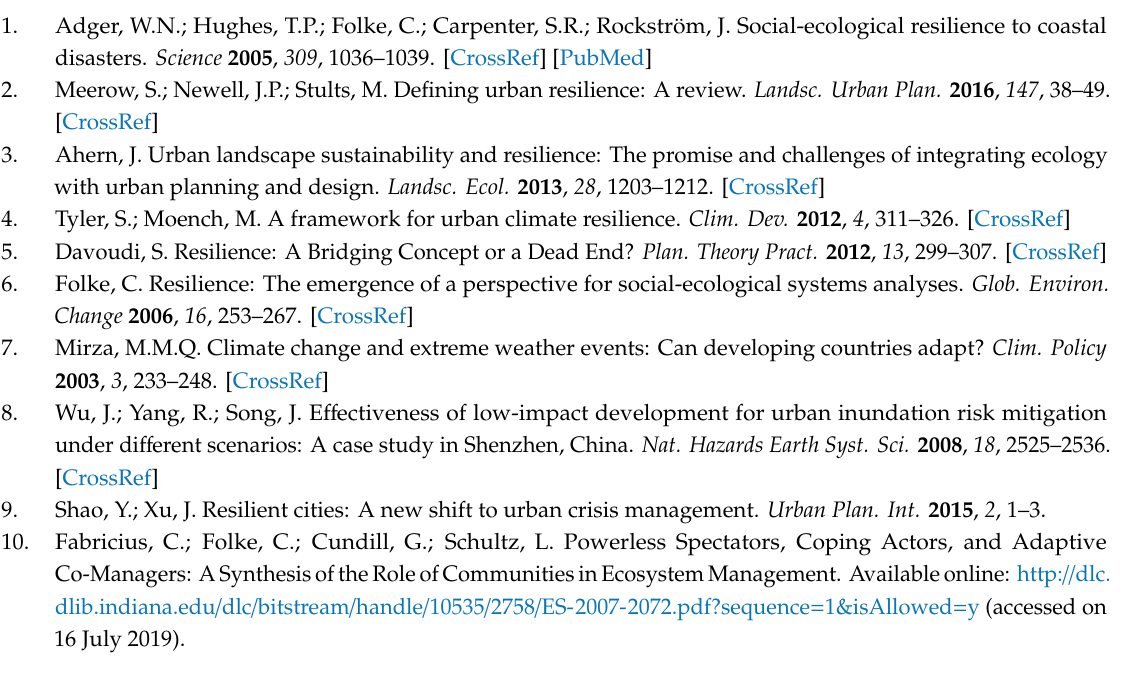
Figure S1: Generalization map of land use; Figure S2: Generalization of pipe junction; Figure S3: Generalization of pipelines; Figure S4: DEM of modeling workspace; Figure S5: Catchments of modeling workspace; Figure S6: Workspace of research area in SWMM; Figure S7: Slope (%) of the research area; Figure S8: Spatial distribution of the test points of urban flooding in the research area; Figure S9: Spatial distribution of depth of urban flooding; Figure S10: Spatial distribution of drainage capacity; Table S1: Parameter types of SWMM; Table S2: Impermeability coe ffi cients of di ff erent land use types; Table S3: Depression storages of di ff erent types of underlying surfaces; Table S4: Range of Manning coe ffi cient (N value); Table S5: Range of calibration parameter of the study area; Table S6: Measurements of urban flooding points for model testing; Table S7: Calibration and validation results; Table S8: Values of some calibration parameters; Table S9: Scoring for drainage capacity. Author Contributions: Supervision, W.L.; Writing, review & editing,